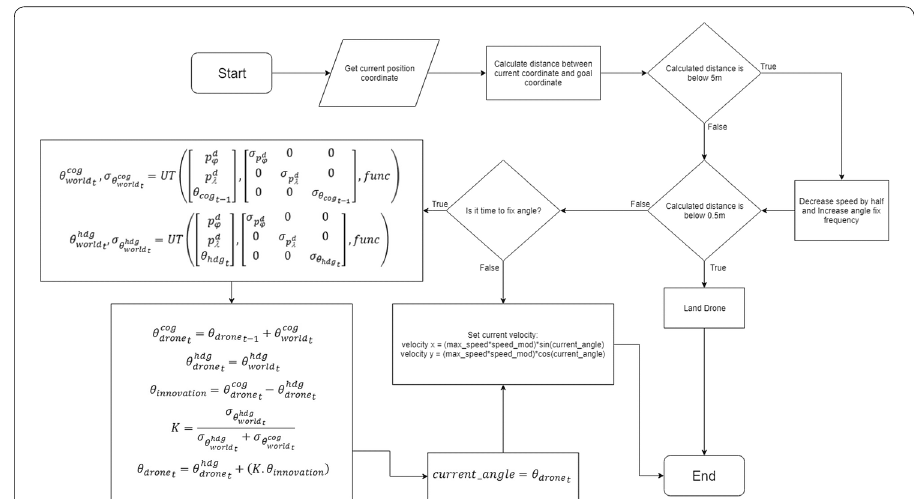
Fig. 9 Drone navigation with course-over-ground